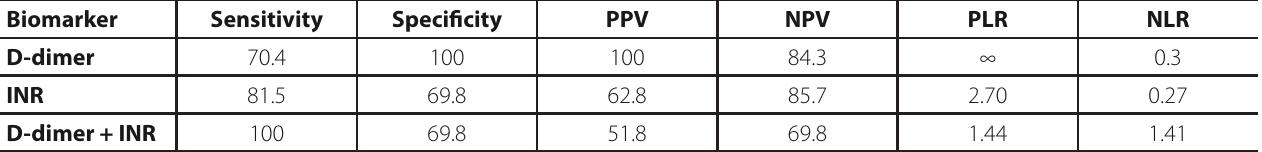
Table 3 . Sensitivity, specificity, PPV, NPV, PLR and NLR of D-dimer, INR and D-dimer + INR.